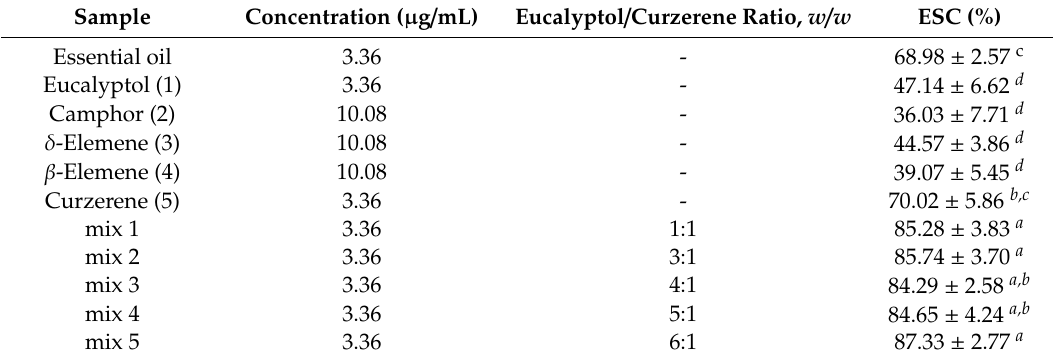
Table 4. Experimental scavenging capacity percentages (% ESC) for isolated compound from Curcuma wenyujin Y.H. Chen et C. Ling essential